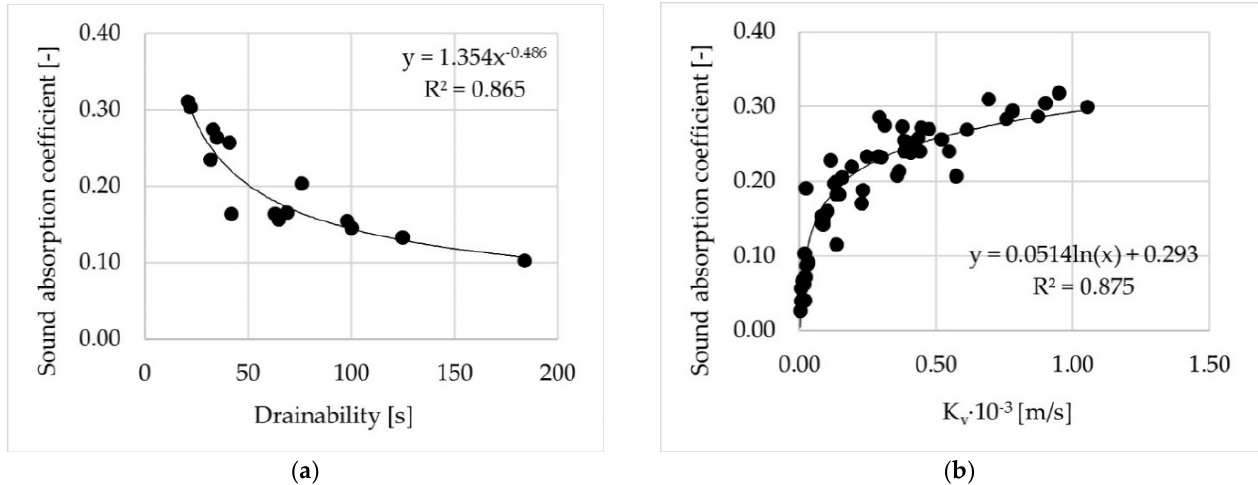
Figure 14. Relationships between water drainability/permeability and sound absorption coefficient for test slabs ( a ) and cylindrical specimens ( b ).